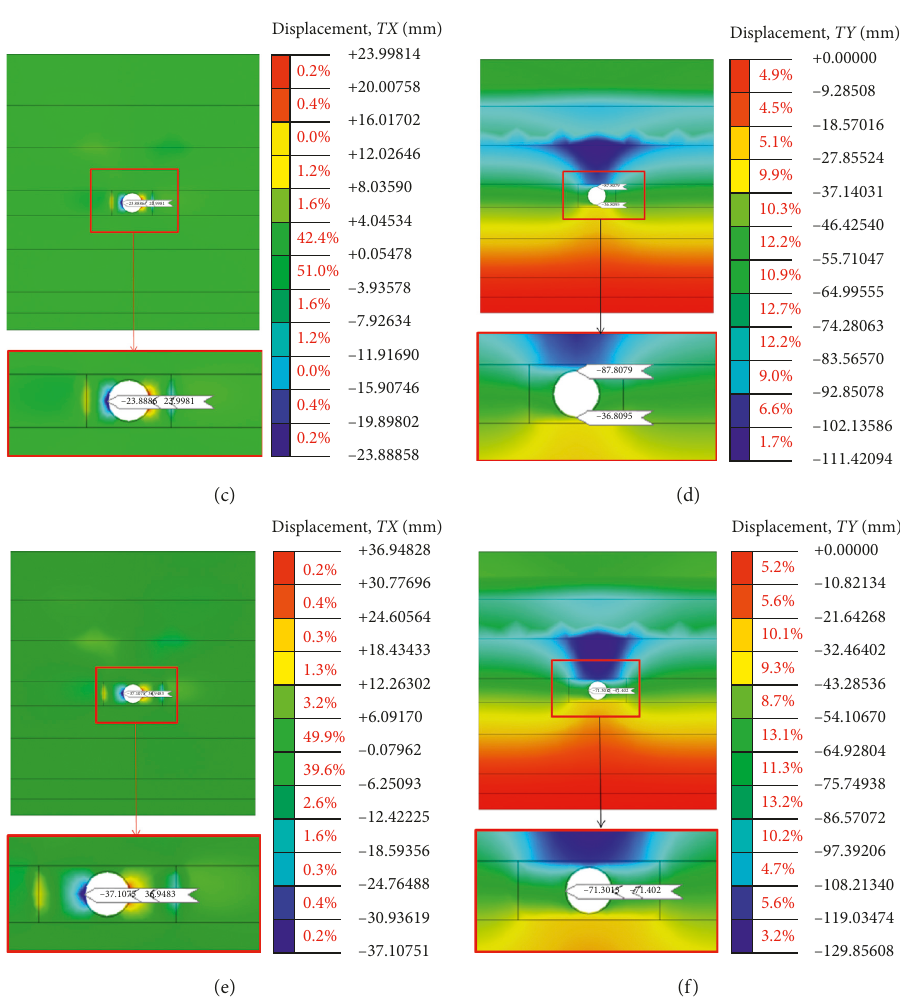
Figure 5: Finite element analysis results. (a) Horizontal deflection for Case 1 (16m). (b) Vertical deflection for Case 1 (16m). (c) Horizontal deflection for Case 2 (16m). (d) Vertical deflection for Case 2 (16m). (e) Horizontal deflection for Case 3 (16m). (f) Vertical deflection for Case 3 (16m). Table 4: Comparisons of numerical analysis results and experimental results. Buried depth